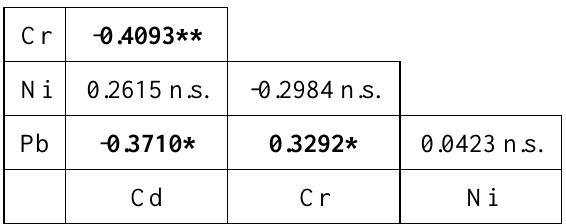
Table 2. Correlation coefficient matrix of trace element concentrations in peatlands (all samples)